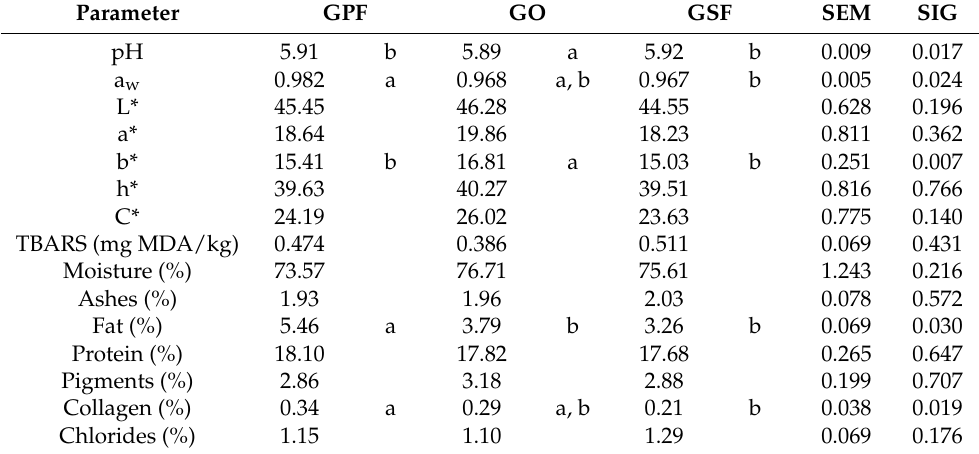
Table 2. Technological and chemical properties of goat meat burgers with pork fat replacement by